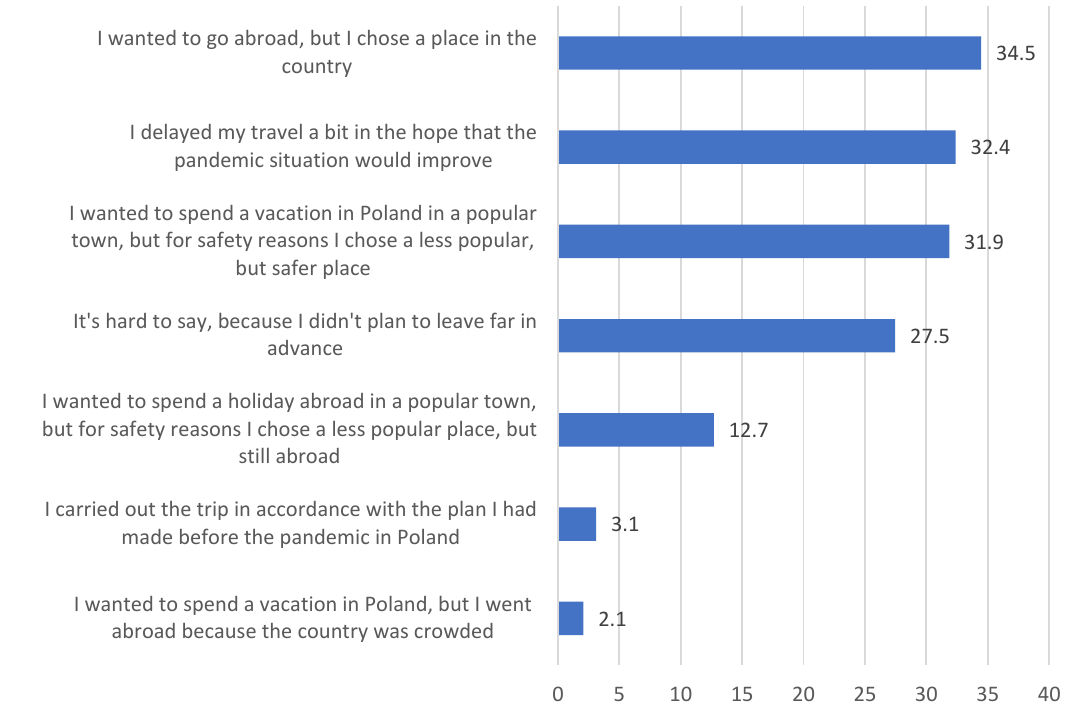
Figure 1. The impact of the COVID-19 pandemic on the change in travel plans of the respondents in 2020 (in %, n = 386). The respondents could indicate more than one answer. Source: self-conducted research.